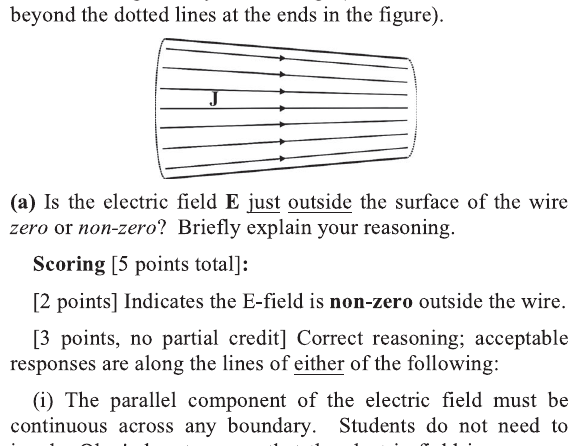
FIG. 1. Problem statement for Q4 of the CURrENT, and related excerpts from the scoring rubric.